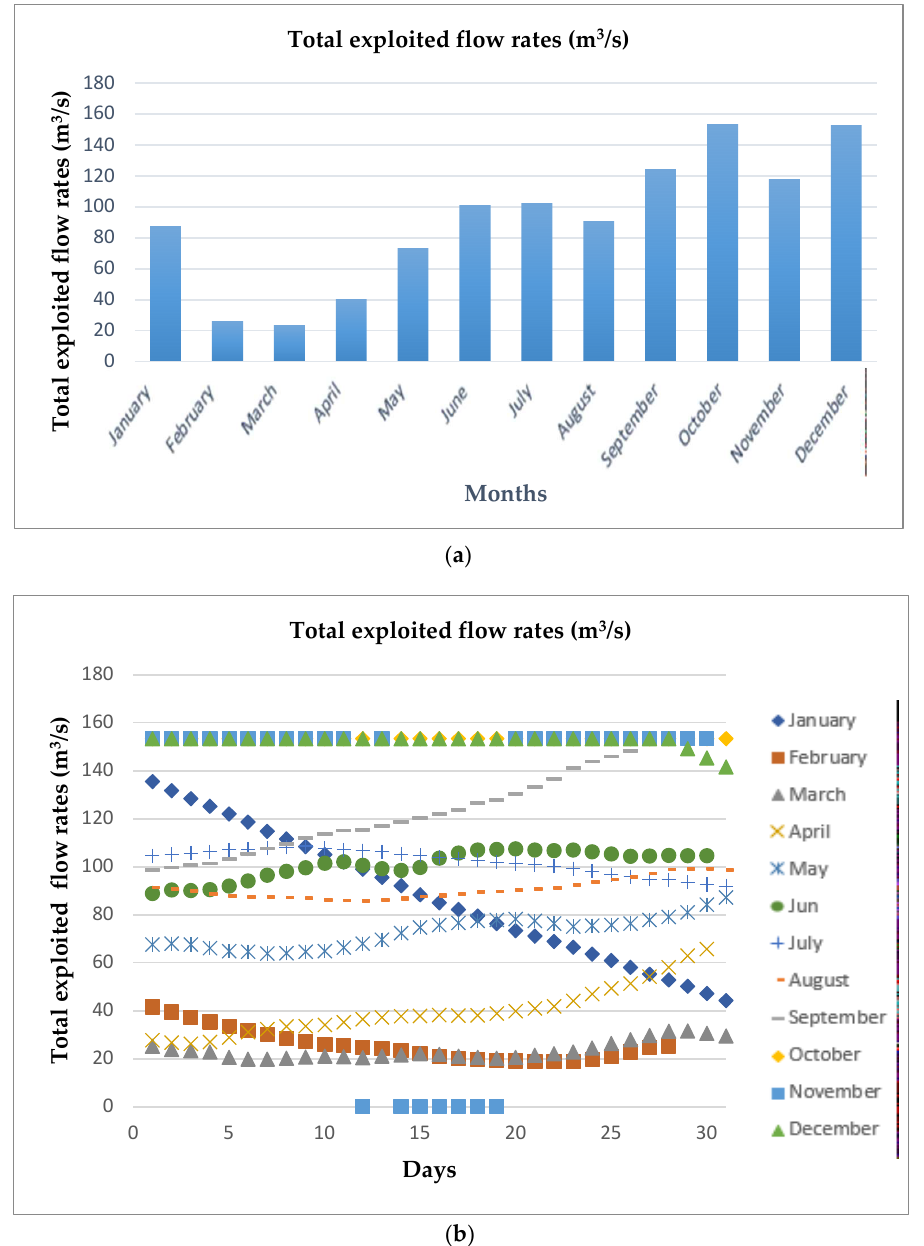
Figure 9. ( a ) Average monthly exploited flow rates histogram and ( b ) average daily exploited flow rates curve.